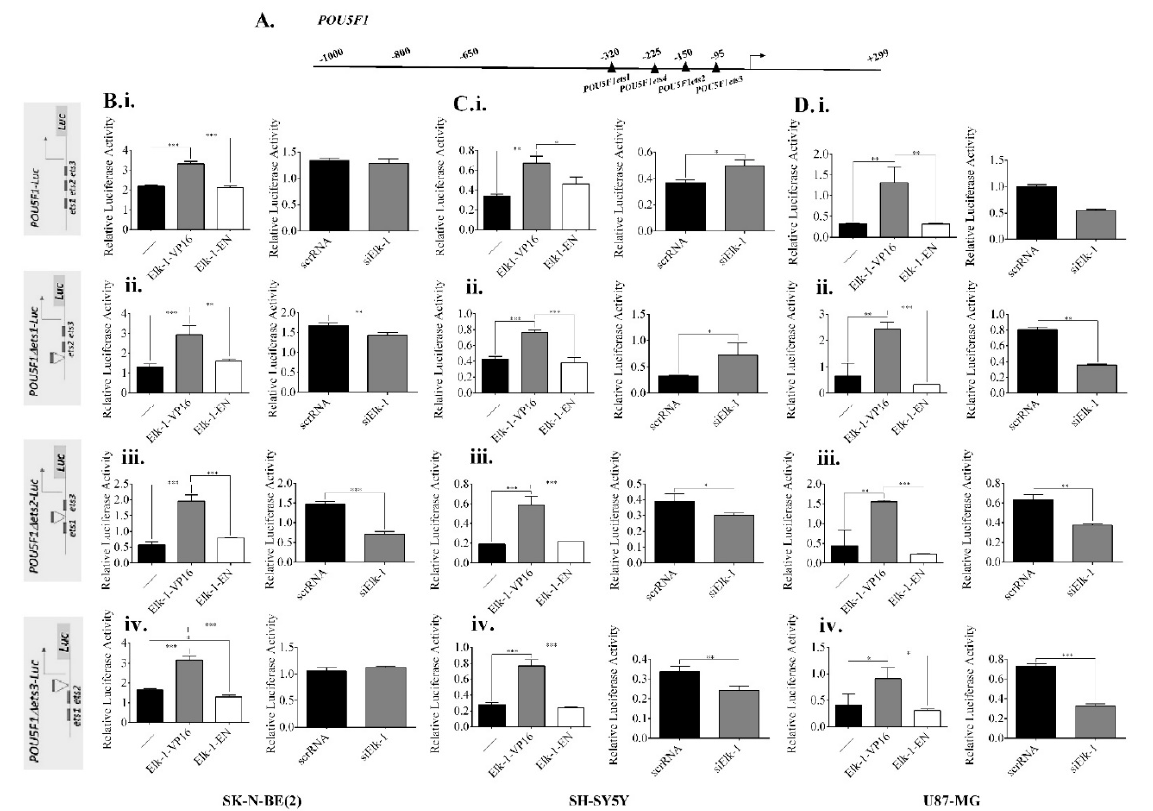
Figure 7. Regulation of POU5F1 promoter by Elk-1. ( A ) Schematic diagram of predicted ets motifs ets1-4 on POU5F1 promoter. Motifs e ts1-3 were predicted to be stronger binding motifs for Elk-1 and were individually deleted to generate POU5F1 ∆ e ts1- Luc, POU5F1 ∆ e ts2- Luc, and POU5F1 ∆ e ts3- Luc reporter plasmids. ( B ) Luciferase assay for ( i ) wildtype POU5F1- Luc and its deletion mutant reporters ( ii ) POU5F1 ∆ e ts1- Luc, ( iii ) POU5F1 ∆ e ts2- Luc, and ( iv ) POU5F1 ∆ e ts3- Luc in SK-N-BE (2) cells after transfection of expression plasmids with Elk1-VP16, Elk1-EN, or empty control plasmid pCDNA3.1 ( left graphs ) or co-transfection of silencing plasmids for scrRNA control or siElk-1 ( right graphs ). Luminometric measurements were normalized to Renilla-luc activity. ANOVA, Tukey’s multiple comparative tests, ** p < 0.01, *** p < 0.001 for left graphs ( i – iv ); unpaired two-tailed t-test, ** p < 0.01 and *** p < 0.001 for right graphs ( i – iv ). C. Luciferase assay for ( i ) wildtype POU5F1- Luc and its deletion mutant reporters ( ii ) POU5F1 ∆ e ts1- Luc, ( iii ) POU5F1 ∆ e ts2- Luc, and ( iv ) POU5F1 e ts3- Luc in SH-SY5Y cells after transfection of expression plasmids with Elk1-VP16, Elk1-EN, or empty control plasmid pCDNA3.1 ( left graphs ) or co-transfection of silencing plasmids for scrRNA control or siElk-1 ( right graphs ). Luminometric measurements were normalized to Renilla-luc activity. ANOVA, Tukey’s multiple comparative tests, * p < 0.5, ** p < 0.01, *** p < 0.001 for left graphs ( i – iv ); unpaired two-tailed t-test, * p < 0.5, ** p < 0.01 for right graphs ( i – iv ). ( D ) Luciferase assay for ( i ) wildtype POU5F1- Luc and its deletion mutant reporters ( ii ) POU5F1 ∆ e ts1- Luc, ( iii ) POU5F1 ∆ e ts2- Luc, and ( iv ) POU5F1 ∆ e ts3- Luc in U87-MG cells after transfection of expression plasmids with Elk1-VP16, Elk1-EN, or empty control plasmid pCDNA3.1 ( left graphs ) or co-transfection of silencing plasmids for scrRNA control or siElk-1 ( right graphs ). Luminometric measurements were normalized to Renilla-luc activity. ANOVA, Tukey’s multiple comparative tests, * p < 0.5, ** p < 0.01, *** p < 0.001 for left graphs ( i – iv ); unpaired two-tailed t-test, ** p < 0.01, *** p < 0.001 for right graphs ( i – iv